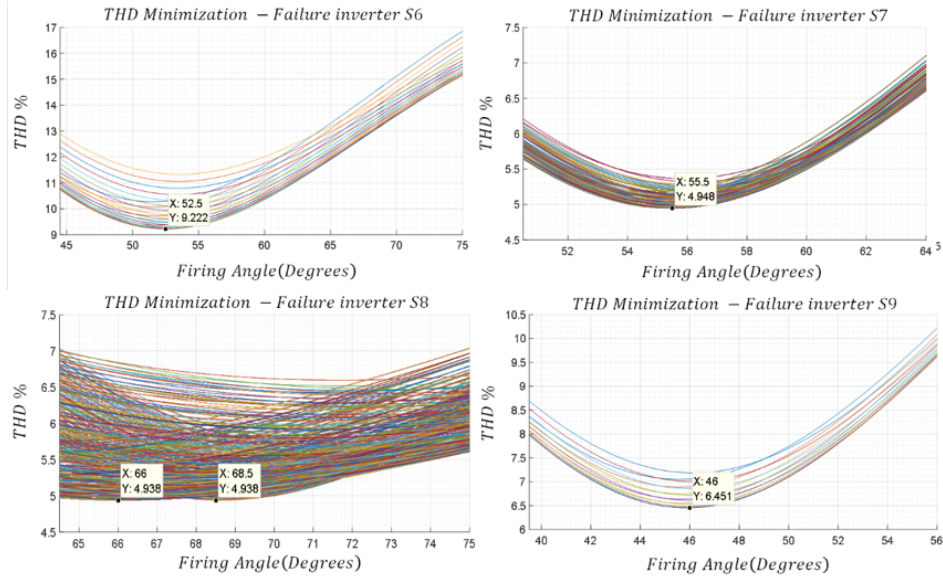
Figure 12. Minimization of the THD for different failed inverter stages.